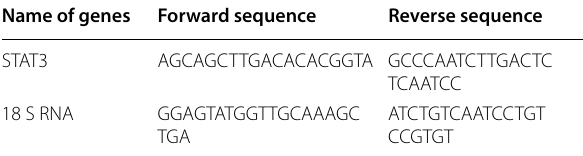
Table 1 Clinical characteristics of GBM patients